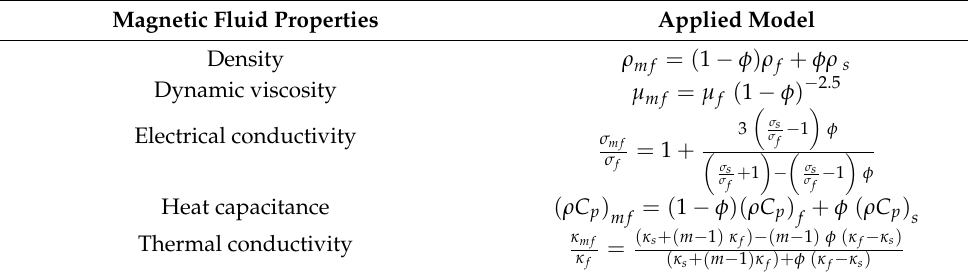
Table 1. Thermophysical properties of the magnetic fluid model [46–48]. Magnetic Fluid Properties